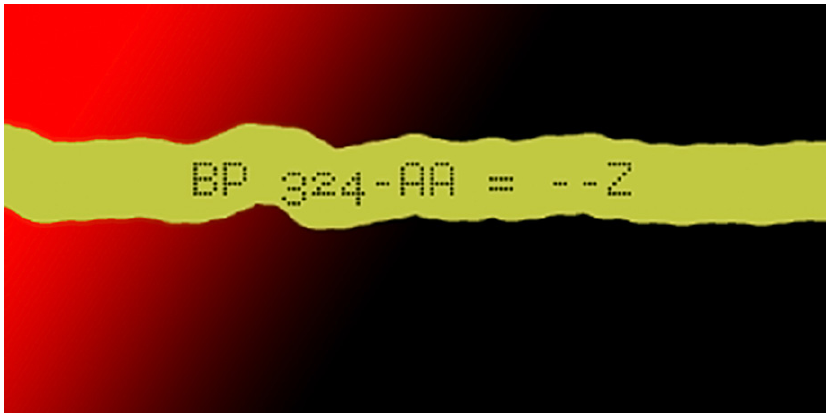
Figure 17. Example of an image generated synthetically for CNN training. Source: Ciebiera K.